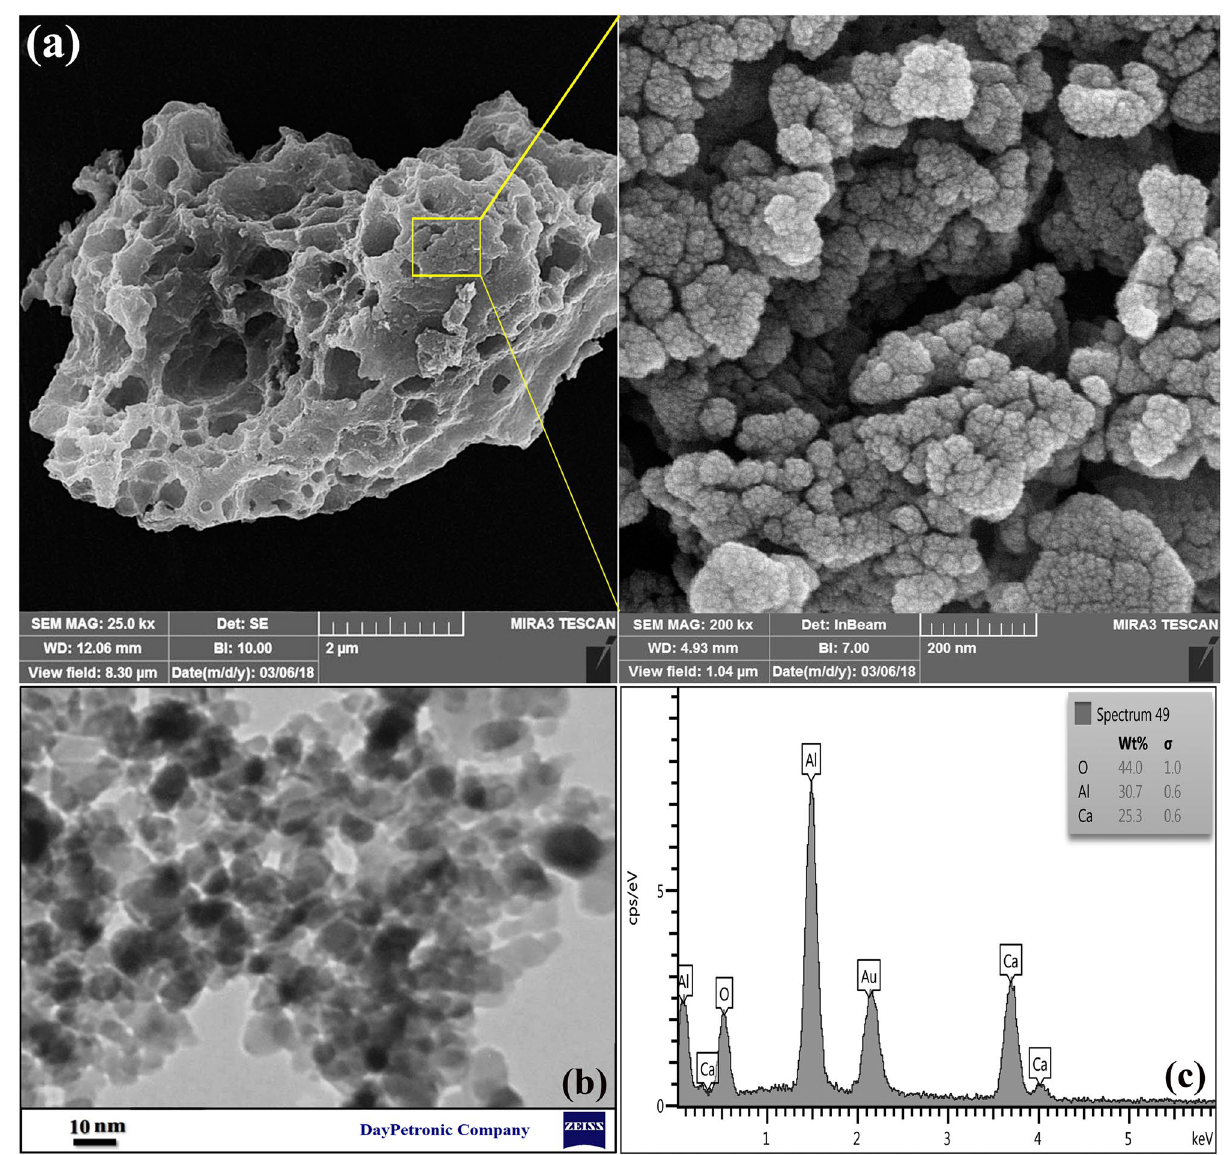
Figure 3. ( a ) SEM images, ( b ) TEM image, and ( c ) EDX analysis of meso-CaAl 2 O 4 The structure and phase purity of synthesized meso-CaAl 2 O 4 was investigated by XRD and are shown in Fig. 4a. As can be seen, the successful synthesis of meso-CaAl 2 O 4 can be proved according to JCPDS Card No. 00-001-0888, and no other impurities are found. The FT-IR spectrum was appliyed to determine the type of surface functional groups of meso-CaAl 2 O 4 and is shown in Fig. 4b. The deformative vibration of the molecules of water is shown by stretching vibration of OH at 3437 cm −1 corresponding to free hydrogen-bonded hydroxyl groups 30 . The nitro groups of the precursors are responsible for other minor peaks shown at 1122 cm −1 and 1254 cm −135 . The stretching vibration of the M–O bond (M=Al, Ca) is seen with the strong absorption band appeared at 823 cm −1 . The stretching vibration of the Ca–O bond is indicated at 617 cm −1 and 436 cm −1 . The band at 528 cm −1 indicates the existence of aluminium ions confirming by the stretching vibration of Al–O. The bands at 1727 cm −1 and 2925 cm −1 are related to the existence of citrate ions that still present after calcination at 700 °C 26 . The surface area and pore structure properties of Meso-CaAl 2 O 4 were evaluated using N 2 adsorp- tion/desorption isotherm, BET specific surface areas, and BJH pore size distribution analyses. According to the classification of IUPAC, the N 2 adsorption/desorption isotherm of meso-CaAl 2 O 4 (Fig. 4c) is a type V isotherm with a hysteresis loop of type H1, which is mostly associated with mesoporous structures. In addition, type H1 is often associated with porous materials, which consist of narrow pore-size distribution 36 . These findings men- tion the fact that meso-CaAl 2 O 4 has a mesoporous structure, which is also seen in the SEM images. According to result of the BET, the adsorbent had 1.39 cm 3 g −1 and 148.5 m 2 g −1 of total pore volume and specific surface area, respectively. To further determine the pore size distribution of meso-CaAl 2 O 4 , the BJH equation was employed. According to IUPAC classification, pores < 2 nm are referred to as microporous, the pores ranging